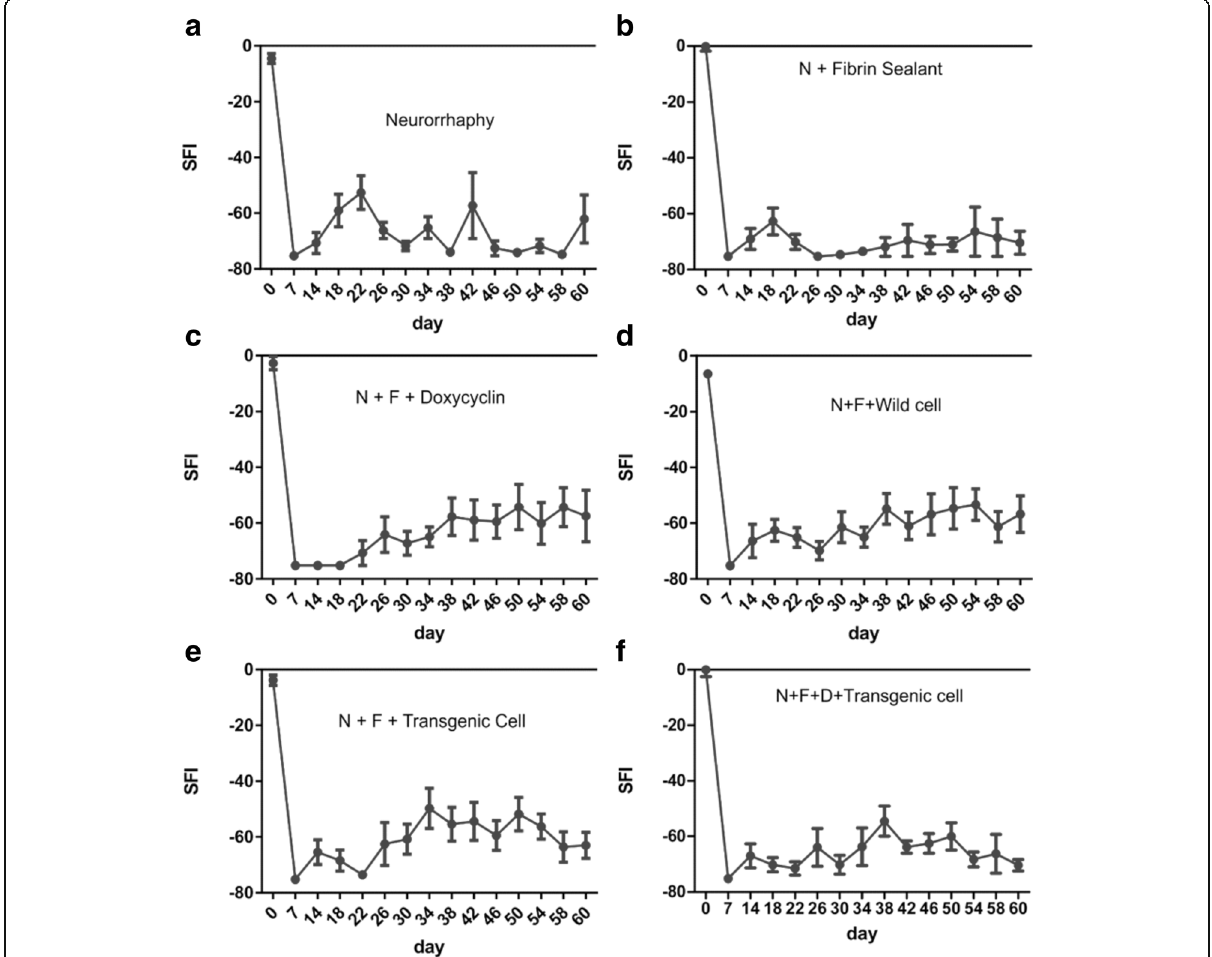
Fig. 7 The results achieved from Catwalk test separated by groups and calculated using the SFI index. a Neurorrhaphy group. b Neurorrhaphy + heterologous fibrin sealant. c Neurorrhaphy + heterologous fibrin sealant + doxycycline. d Neurorrhaphy + heterologous fibrin sealant + wild type hESCs. e Neurorrhaphy + heterologous fibrin sealant + transgenic cells (non-induced). f Neurorrhaphy + heterologous fibrin sealant + doxycycline + transgenic cells